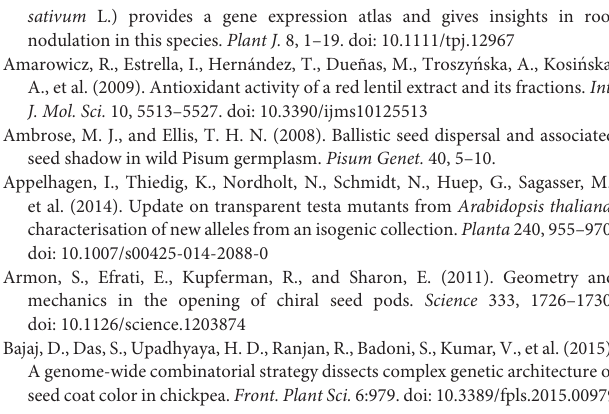
Table S1 | Germination characteristics of parental and RIL lines. Table S2 | Summary statistics for MACE sequencing data and annotation to the Pisum mRNA sequences from NCBI and to the contigs based on the de novo assembly of sequences. Table S3 | List of primers used for qRT-PCR. Table S4 | Complete set of DEGs detected in seed dormancy and pod dehiscence experiments, between wild and cultivated parental genotypes as well as RILs, with indicated homology to annotated pea transcriptome (Tayeh et al., 2015) and MACE expression values. Table S5 | GO annotations of seed dormancy genes. Table S6 | GO annotations of pod dehiscence genes. Figure S1 | Germination indexes of all 126 RIL lines tested dat 25C over the period of 7 days. Ordered by cummulative germination percentages (A) with shown Coefficient of velocity (B) , Timson indexes (C) , and Mean germination time (D) arranged accordingly. Figure S2 | Seed coat transverse sections from extrahilar region: Cameor (a) , JI92 (b) , JI64 (c) , and VIR320 (d) . UV excited autofluorescence ( a–d): white arrow, cuticle; asterisk, light line. Sudan Red 7B staining of terminal parts of macrosclereids (e–h) : white arrow, cuticle; black arrow, lipidic material different from the cuticle). Aniline blue fluorochrome staining under UV excitation (i–l) : asterisk, light line; white arrow, the edge between pigmented and non-pigmented interface of JI92, inlay in (i) callose immunodetection (blue excitation); scale bars = 25 µ m) Figure S3 | Seed coat transverse sections from extrahilar region: Cameor (a) , JI92 (b) , JI64 (c) , and VIR320 (d) . Metachromatic toluidine blue staining is indicative of high density of polyanionic surface (a–d) : asterisk, light line. Toluidine blue staining after mild acid treatment (e–h): black arrow = the edge between pigmented and non-pigmented interface of JI92; scale bar = 50 µ m. Figure S4 | KEGG phenylpropanoid (A) and flavonoid (B) pathways of DEGs between dormant and nondormant seeds. Figure S5 | KEGG phenylpropanoid pathway of DEGs between dehiscent and indehiscent pods. Figure S6 | Strictly homozygous SNP between dehiscence and indehiscence RIL bulks mapped to the eight Medicago truncatula